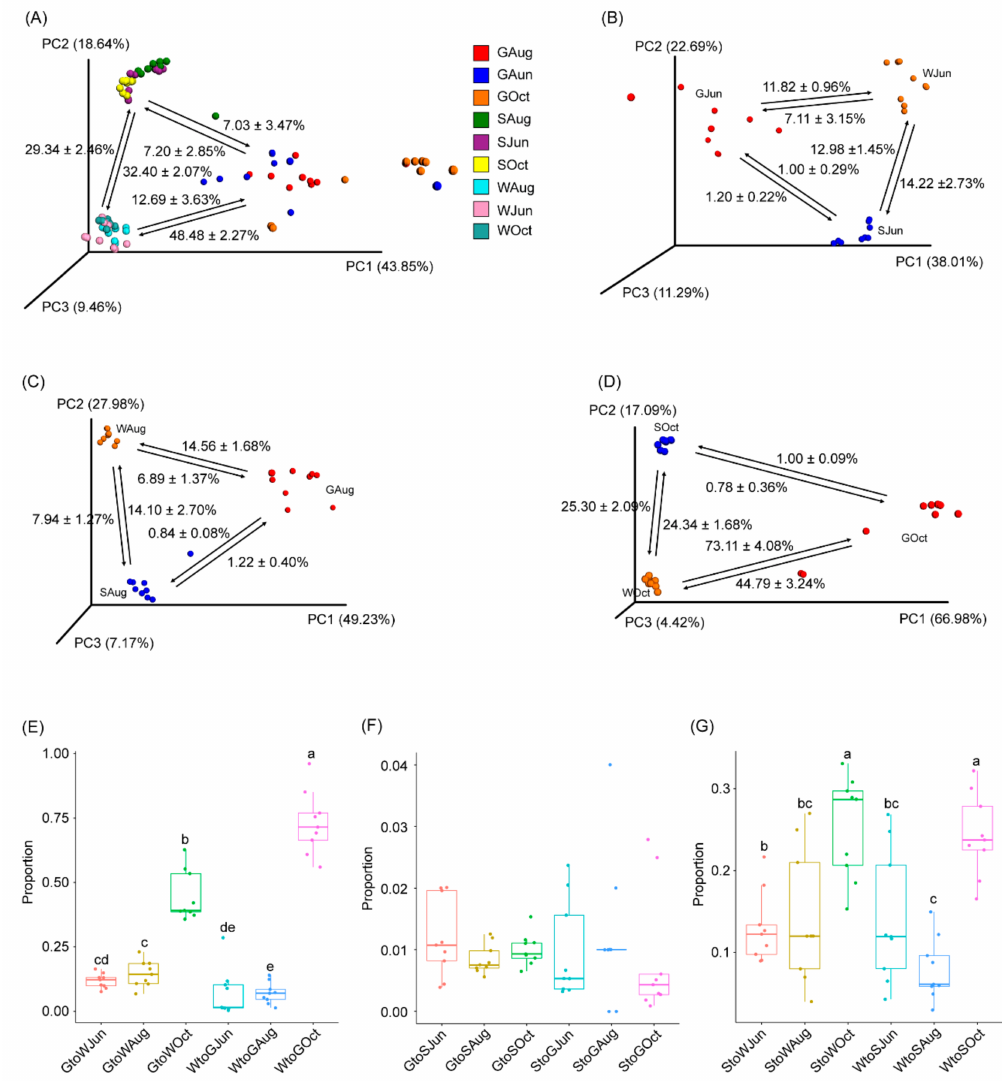
Figure 4. PCoA profiles along with source tracking results highlight the connection between the largemouth bass gut microbiota with pond water and sediment microbiota. ( A ) All samples, ( B ) samples collected in June, ( C ), samples collected in August, ( D ) samples collected in October, ( E ) the proportion of bacteria subjected to exchange between the gut microbiota and pond water microbiota, ( F ) the proportion of bacteria subjected to exchange between the gut microbiota and pond sediment microbiota, and ( G ) the proportion of bacteria subjected to exchange between pond water and sediment microbiota. GJun, GAug, and GOct indicate largemouth bass gut samples collected in June, August, and October, respectively. SJun, SAug, and SOct indicate pond sediment samples collected in June, August, and October, respectively. WJun, WAug, and WOct indicate pond water samples collected in June, August, and October, respectively. Different lowercase letters at the top of the box indicate significant differences between the two